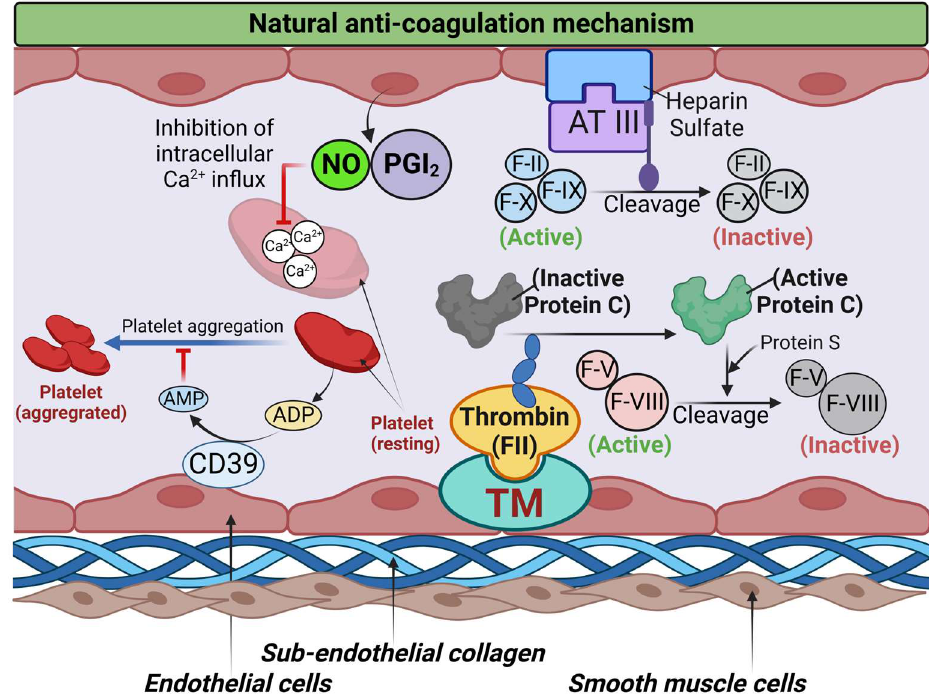
Figure 1. Natural anti-coagulation mechanism. In the normal physiological condition, nitric oxide (NO) and prostacyclin (PGI2) secreted from intact endothelial cells inhibit platelets, keeping them inactive and preventing them from binding to the endothelial lining. NO and prostacyclin act on platelets to inhibit intracellular Ca 2+ influx in platelets, thus inhibiting the release of granules from platelets and preventing platelet aggregation. Another endothelial cell molecule, CD39 (an adenosine diphosphatase (ADPase)) converts ADP (a potent platelet-derived platelet activator) to adenosine monophosphate (AMP), therefore restricting the availability of ADP to initiate platelet activation followed by platelet aggregation. Coagulation factors are also inactivated by antithrombin III (ATIII), a protein bound to endothelial cells by a glycosaminoglycan, heparin sulfate, and activated protein C (APC) in association with protein S. ATIII cleaves circulating clotting factors (Factor II (F-II), Factor IX (F-IX), and Factor X (F-X)) and inactivates them. Protein C is activated by thrombin (F-II)